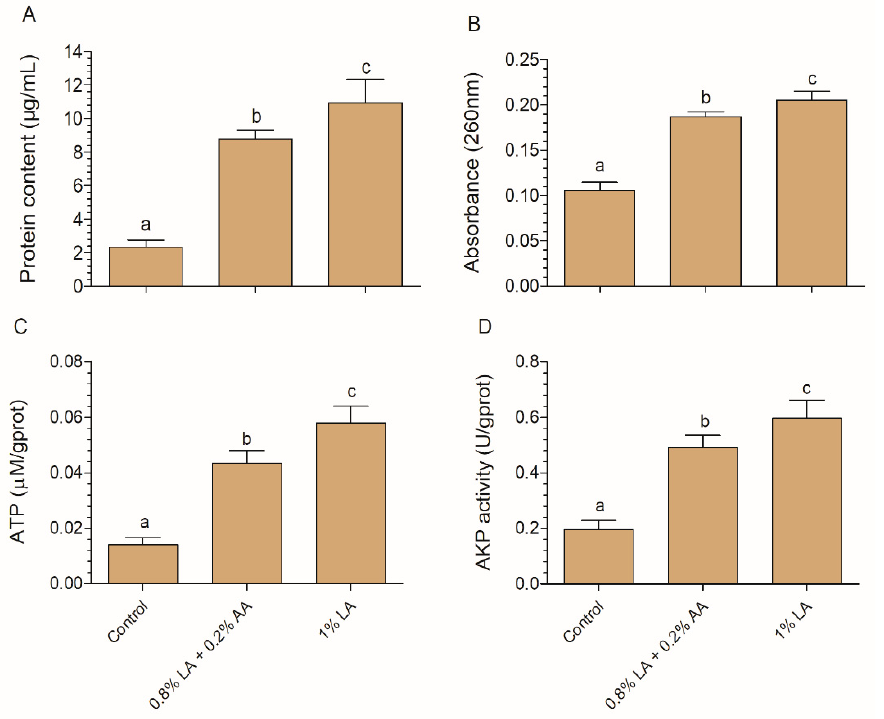
Figure 5. Effects of an acid mixture and lactic acid on protein content ( A ), nucleotide content ( B ), ATP content ( C ), and AKP activity ( D ) in Escherichia coli O157:H7. Different letters above the columns indicate significant differences ( p < 0.05 ). AA, acetic acid; LA, lactic acid .